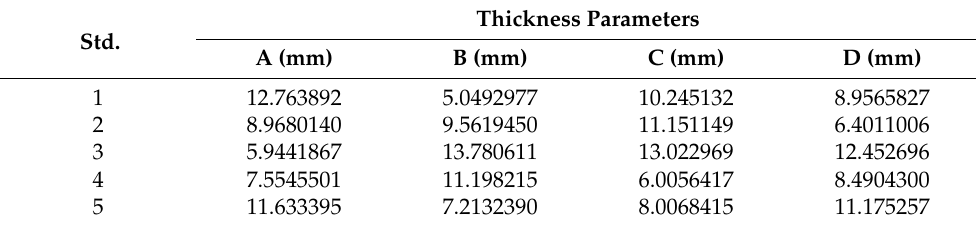
Table 5. Details of five arbitrarily selected test points.